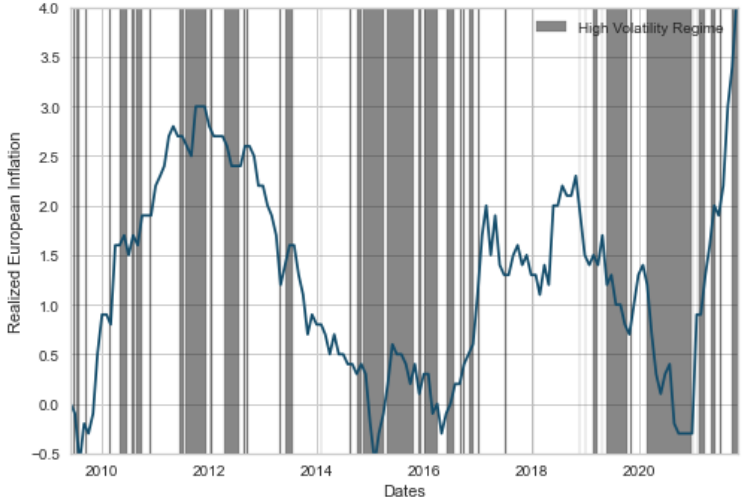
Figure 2. Realized inflation through volatility